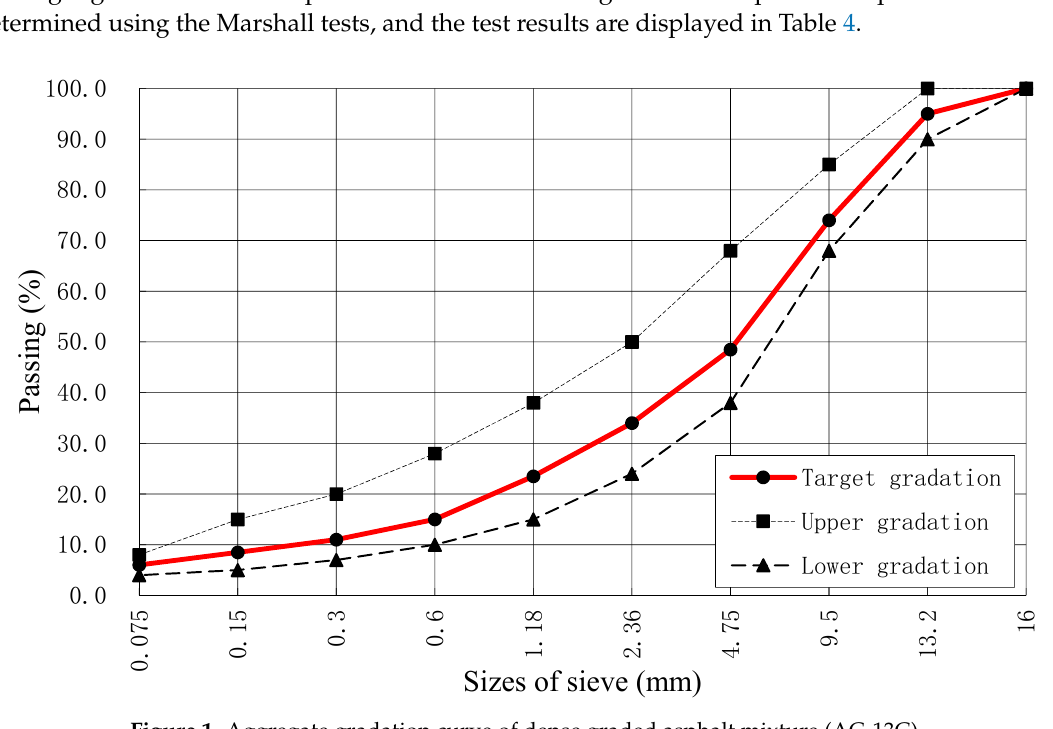
Figure 1. Aggregate gradation curve of dense graded asphalt mixture (AC-13C). Table 4. Results of Marshall test at the optimal asphalt-aggregate